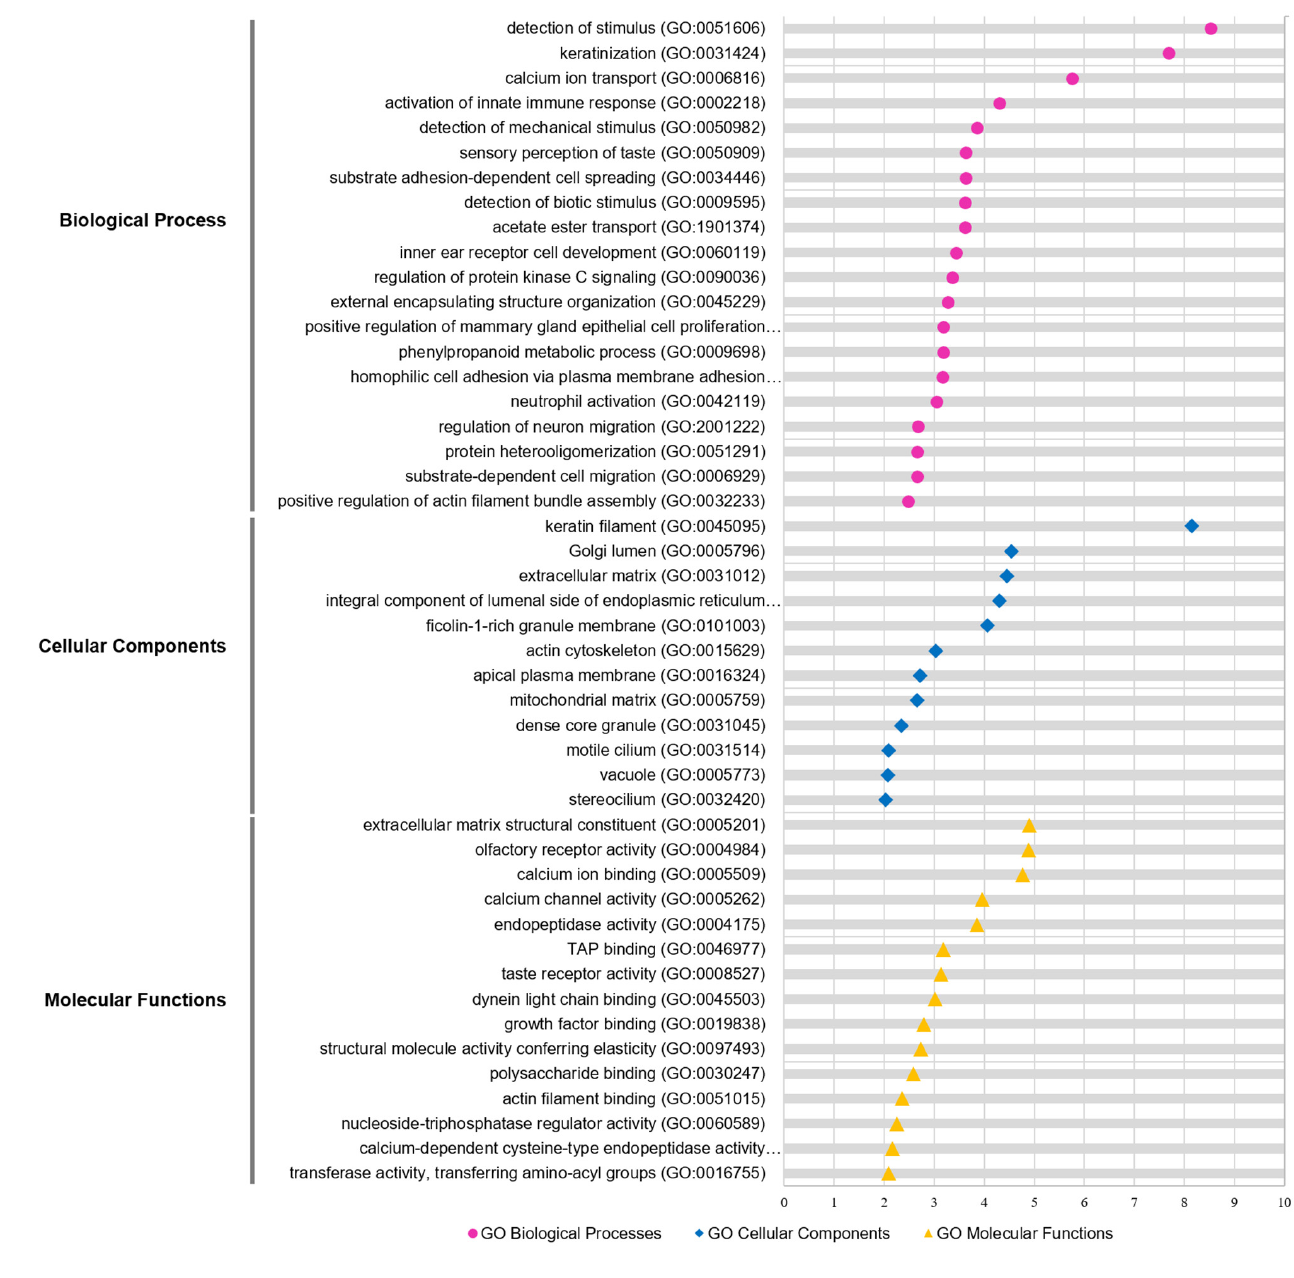
Figure 3. GO functional analysis of candidate genes. GO enrichment analysis of WES genes was retrieved using Metascape software. Significantly ( p < 0.05) enriched GO terms involved in biological process (pink), cellular component (blue), and molecular function (yellow) and branches are presented. The adjusted statistically significant values were negative 10-base log-transformed. The X-axis represents the enrichment scores of the terms − log10( p -value), and the Y-axis represents the enriched GO terms in the pathway. P-value was adjusted by Benjamini–Hochberg FDR. GO, gene ontology.